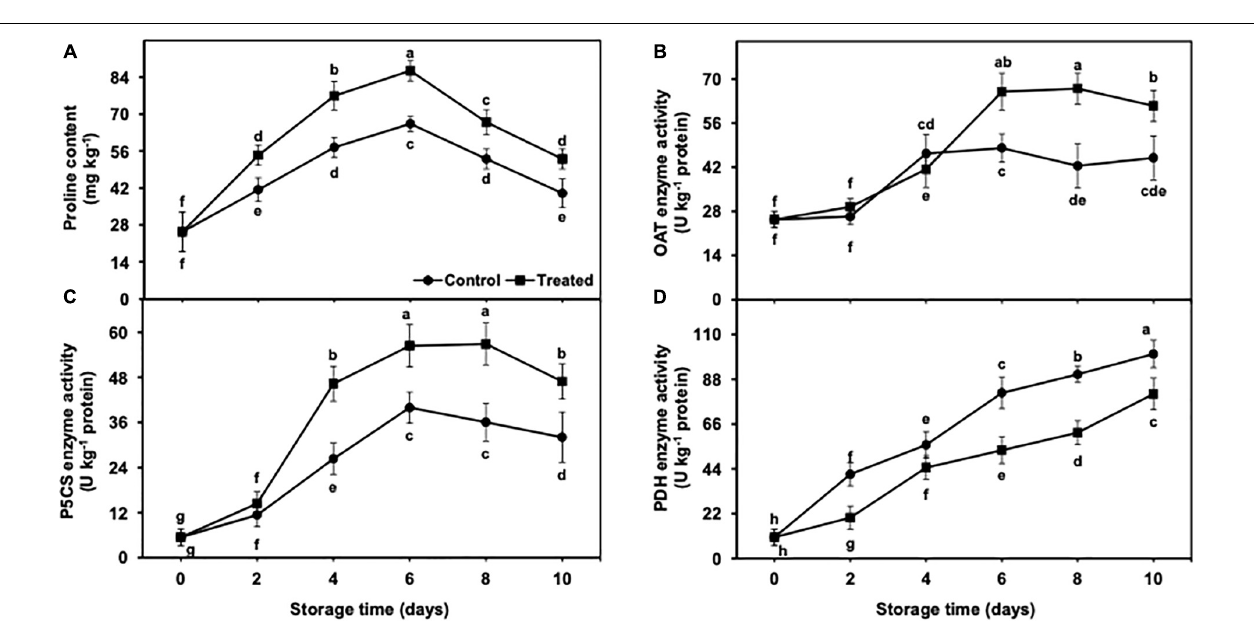
FIGURE 6 | Effect of hydrogen sulfide on GABA content (A) , GAD enzyme (B) and GABA-T enzyme (C) activity in peel of banana fruit. Data are mean of three replications and vertical bars show standard of the means. Different letters show significant difference according to least significant difference test.